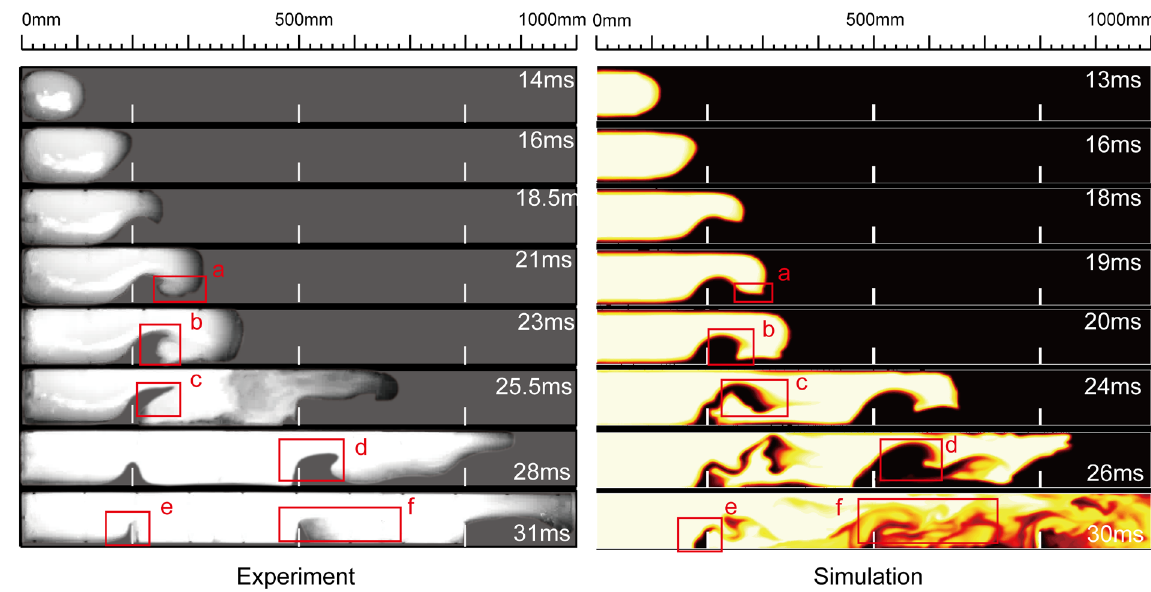
Figure 4. Flame comparison: Some feature comparisons were marked with red boxes a, b, c, d, e, f.